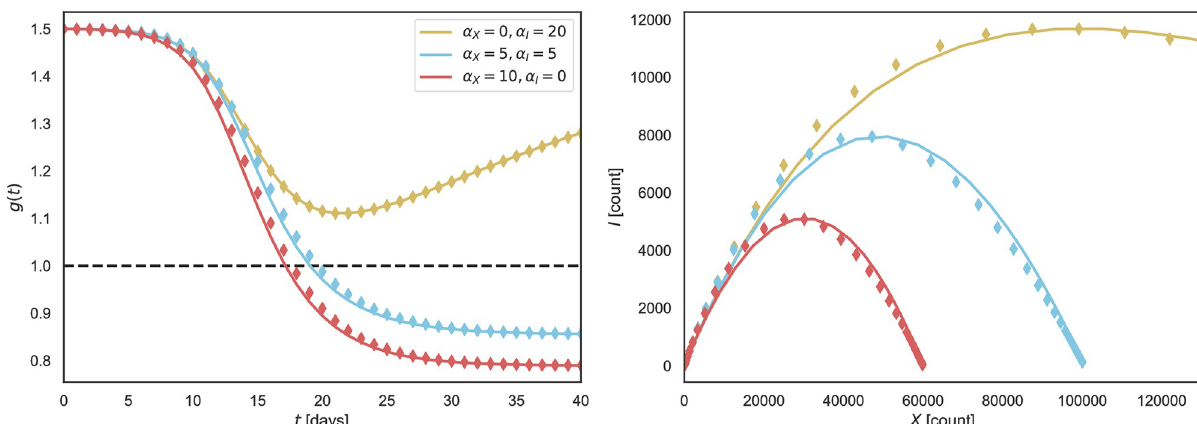
Fig 8. Solutions of the controlled SIR model vs. simulated data. Comparison of g ( t ) and I ( X ) obtained numerically (solid lines) and from simulated daily fatalities (diamonds). See Eq (2) for the effective reproduction factor g = g ( t ) and Eq (16) for the XI representation. Simulated daily and total fatalities were obtained from active cases as Δ F Similarly, the recovered g X (0) = 10, I (0) = 10, R (0) = 0, g (0) = 1.5, and N = 10 6 . See Approximate integration for